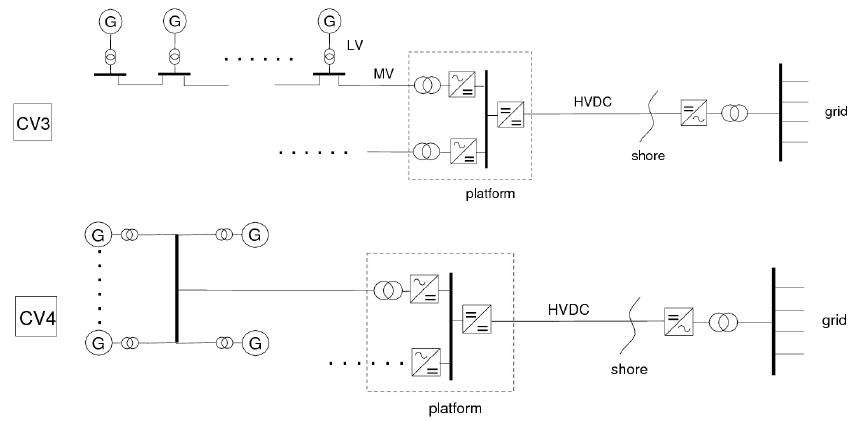
Figure 7 . Cluster-coupled variable-speed HVDC system and step-up chopper.